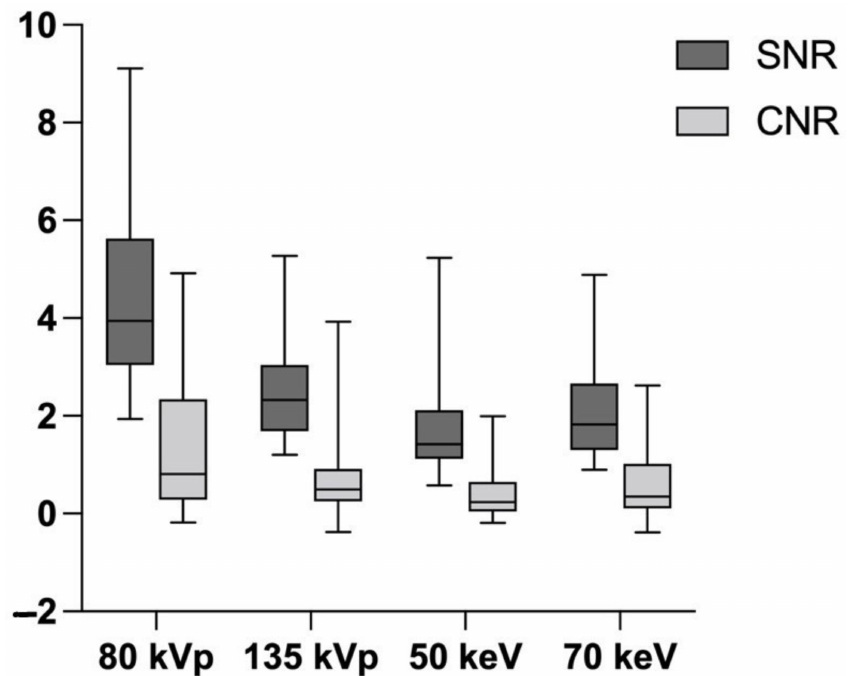
Figure 5. Quantitative assessment of image quality. SNR = signal-to-noise ratio, CNR = contrast-noise ratio. The highest SNR and CNR were shown for CT-S with 80 kVp. CT-S with monochromatic energy levels (50 and 70 keV) provided significantly lower CNR and SNR values, which resulted in lower image